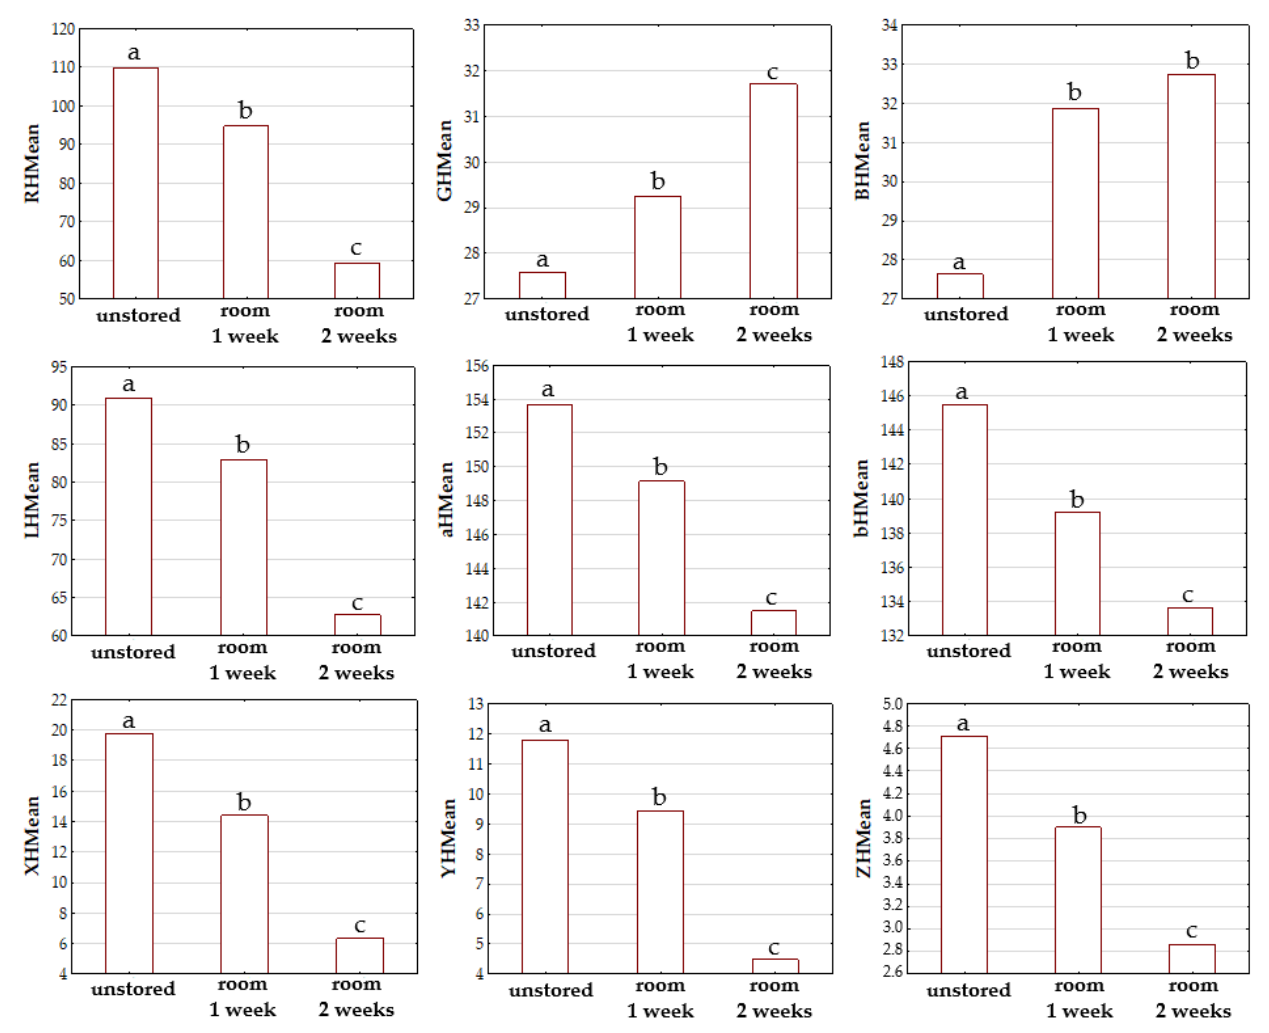
Figure 5. The changes in the values of selected image textures of red currants stored at room temperature. a, b, c—the same letters on one graph denote no statistical differences between samples.